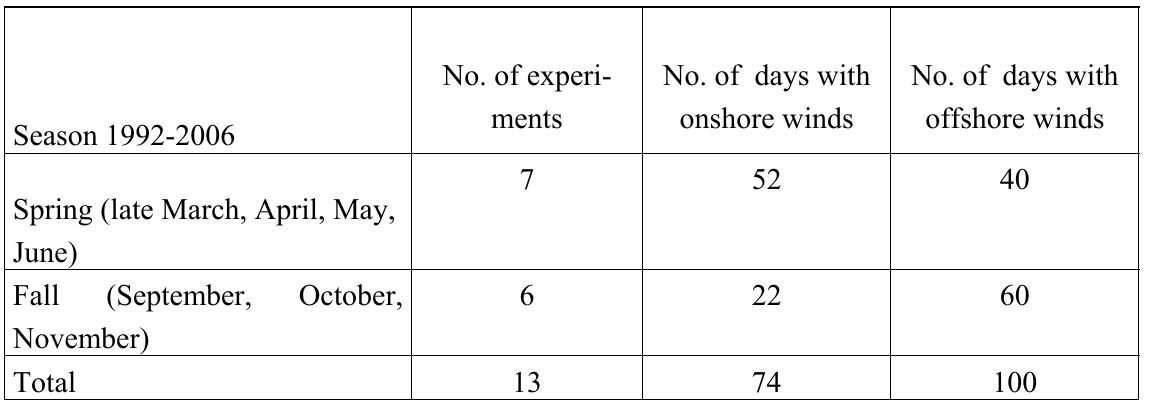
Table 2. Experiments carried out between 1992 and 2006 in the coastal area of the southern Baltic.